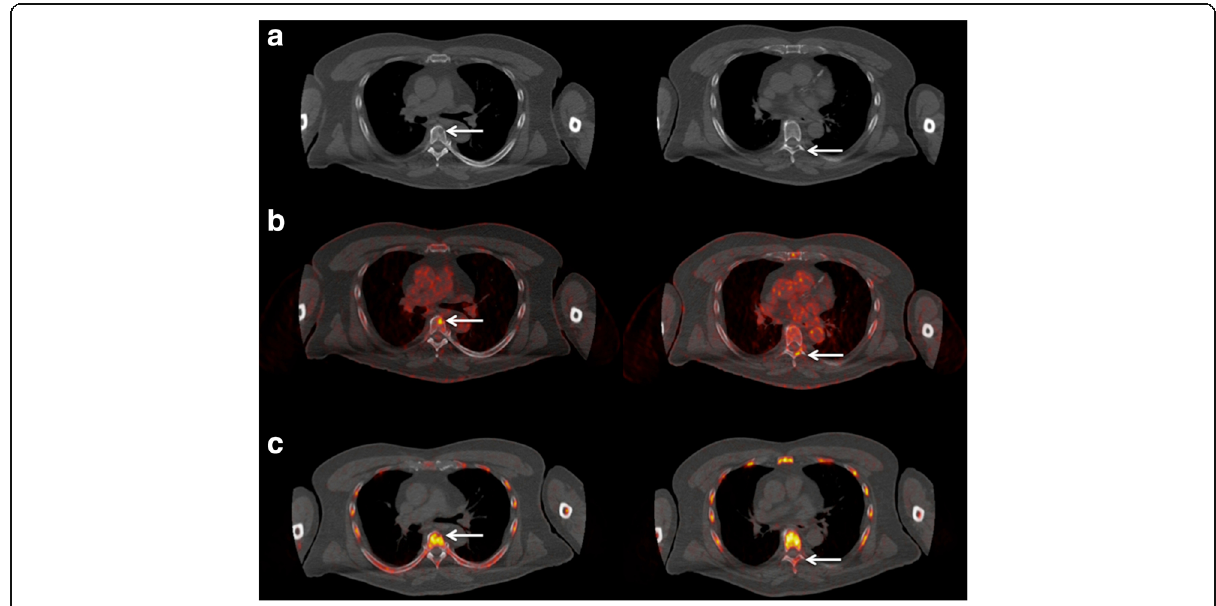
Fig. 5 Transaxial low-dose CT (upper row, a ), 18 F-FDG PET/CT (middle row, b ), and 18 F-FLT PET/CT (lower row, c ) at the thoracic level of a 65-year- old male patient with initial diagnosis of MM. Intense 18 F-FDG accumulation ( b ) in osteolytic areas in the sixth thoracic vertebra (left column, a ) and seventh thoracic vertebra (right column, a ), reflecting active MM lesions. In contrary, 18 F-FLT PET/CT revealed reduced tracer accumulation in the MM lesions ( c ), lower than the normal bone marrow